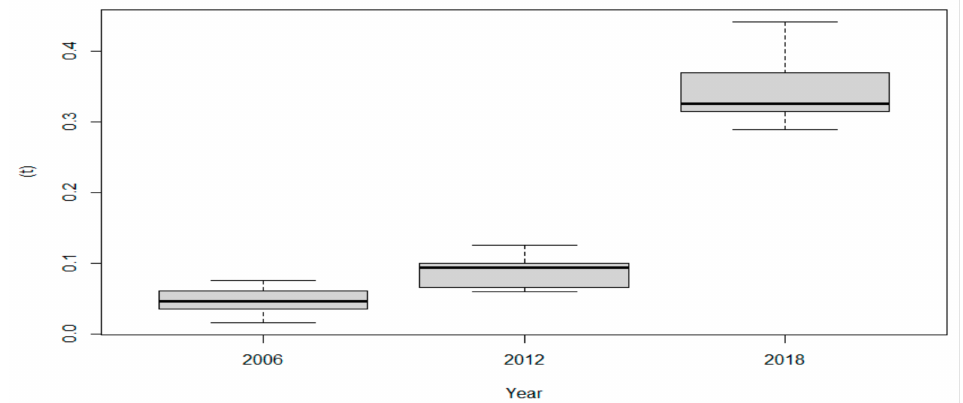
Figure 4. Development of separated waste per household.